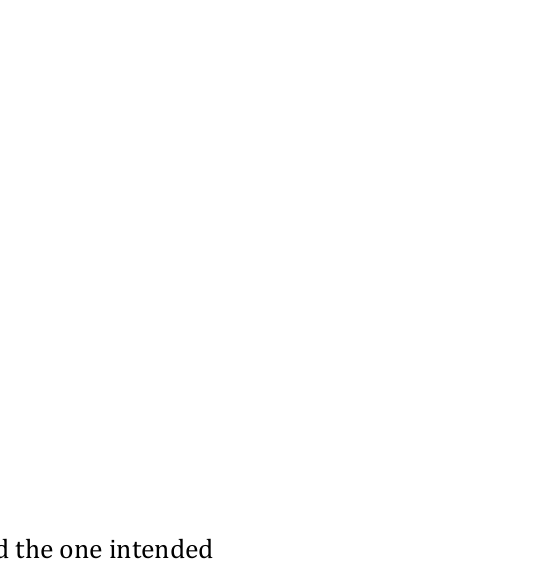
Figure 2: Semantic Errors Classification ( Adapted from Hemchua and Schmitt (2006:12) Semantic